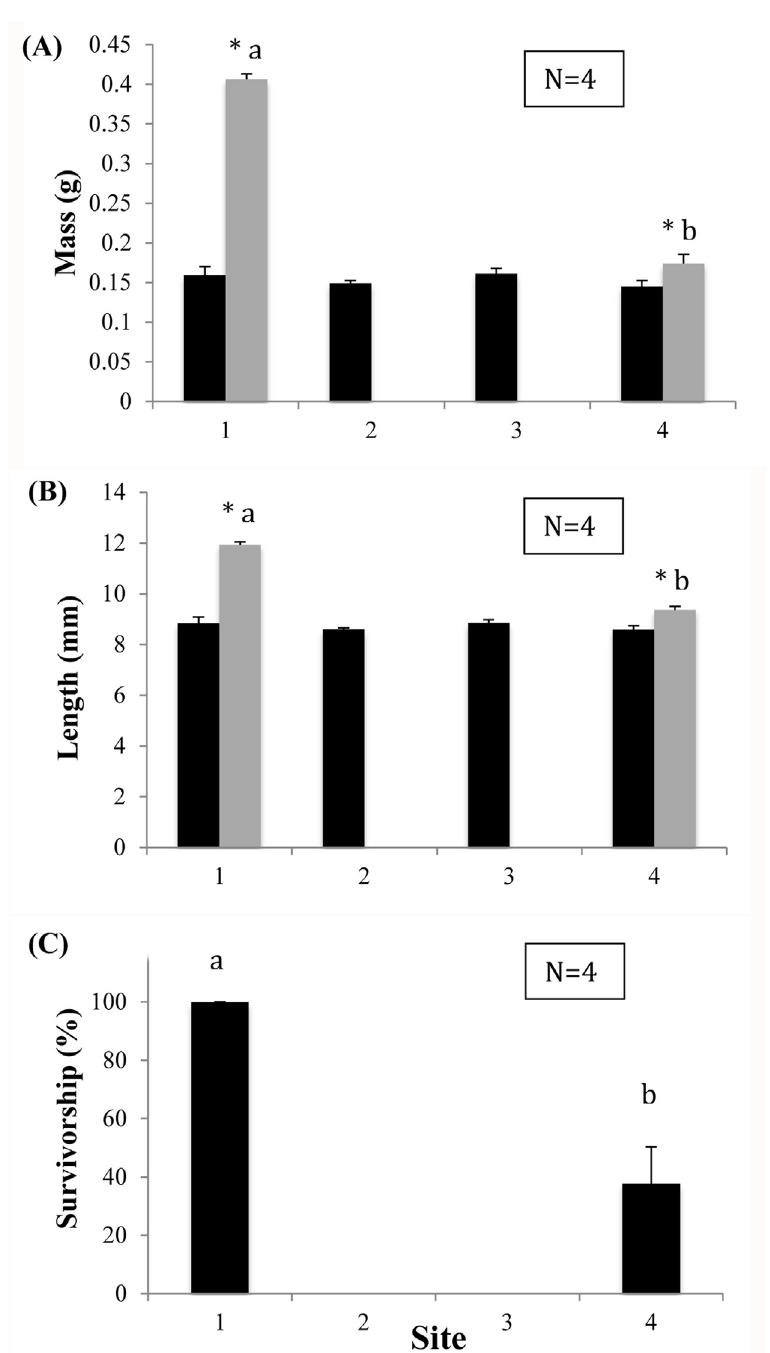
Fig 3. Growth and survival of the non-native Asian clam ( Corbicula fluminea ) after 72 days of exposure to effluent at four sites in Wilbarger Creek (Texas, USA). (A) Mean whole wet mass in grams at day 0 (black bars) and day 72 (gray bars) of the study; (B) mean total length in millimeters at day 0 (black bars) and day 72 (gray bars) of the study; (C) mean percent survivorship at day 72. Error bars represent ± 1 standard error. Columns with the same letter were not statistically different from each other at p = 0.05. An asterisk next to a column denotes significant change in that parameter between day 0 and day 72. Site 1, the reference site, was located upstream of the discharge, Site 2 just below the discharge, and Sites 3 and 4 downstream of the